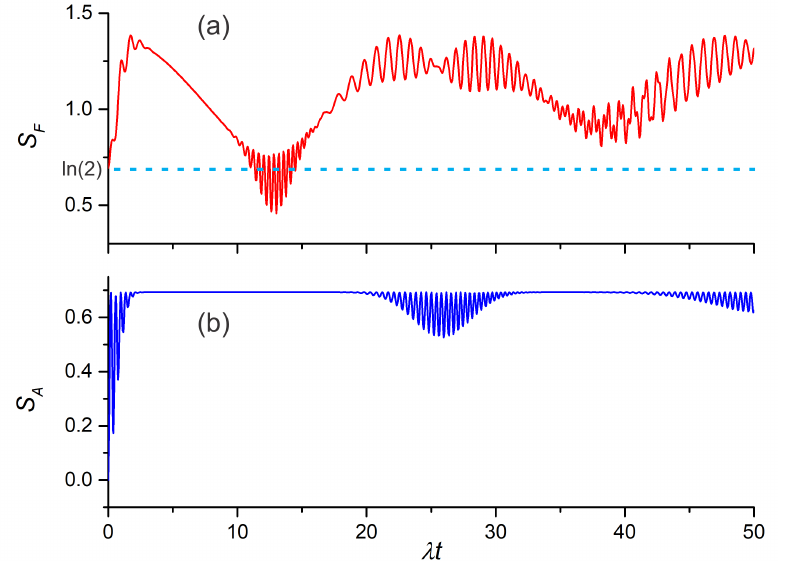
Figure 3. The evolution of the: ( a ) field entropy and ( b ) and atom entropy; for a Kaleidoscope-State as a function of the scaled time λ t with n = 2 and α = 4.0. The initial value of field entropy is calculated as ln ( 2 ) and is indicated in the figure by a dotted line.